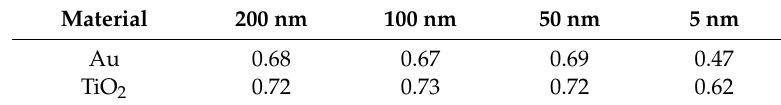
Figure 2. Comparison between adsorption free energies for the experimentally and computationally derived protein structures, showing all radii simultaneously for gold ( top left ), anatase ( top right ) and the combined data sets ( bottom left ). Bottom right: The sets of relative error of the two materials with blue bars indicating the data for gold and orange for anatase presented as probability density functions (PDF), i.e., normalised counts. A smoothed line (blue for gold, red for anatase) is added to guide the eye and distinguish between overlapping regions. Table 6. R 2 values for a linear best fit between the experimental and computational protein 3D structures for spherical NPs of various radii R , allowing for both a linear and constant term.